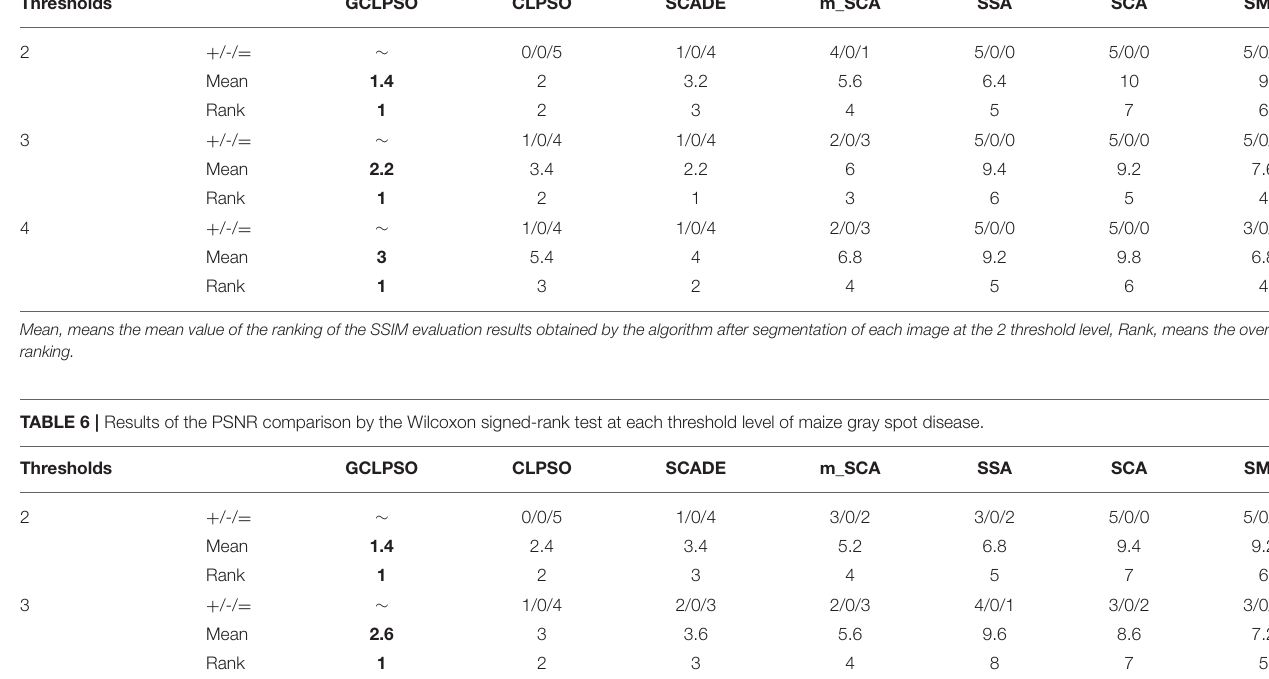
TABLE 5 | Results of the FSIM comparison by the Wilcoxon signed-rank test at each threshold level of maize gray spot disease. Thresholds